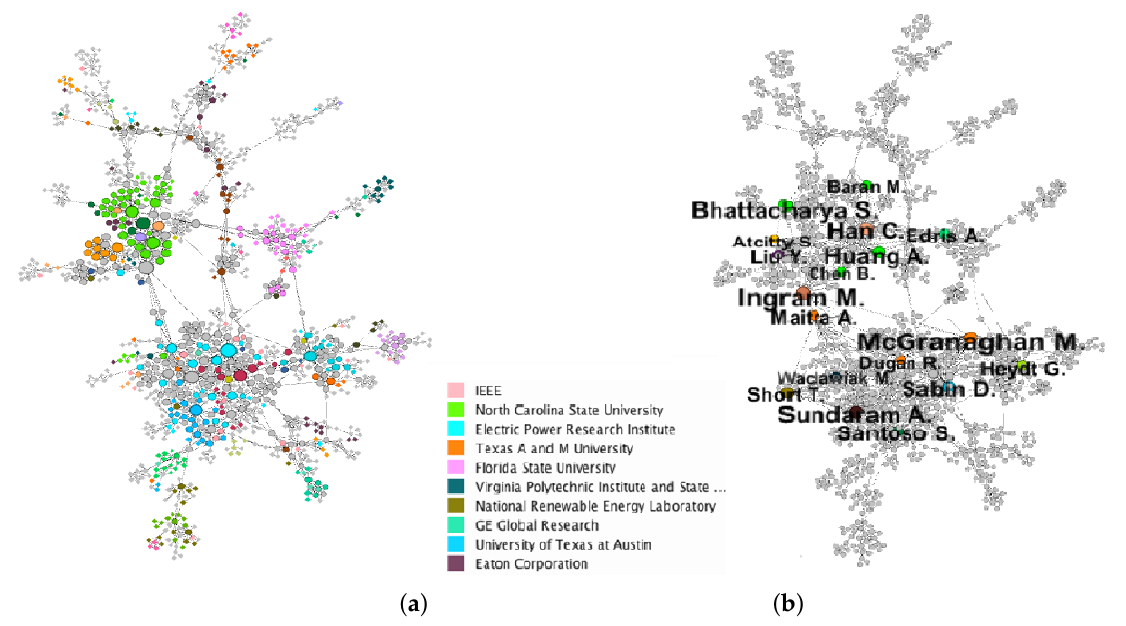
Figure 9. ( a ) collaborations among North American researchers working in power quality; ( b ) researchers with eigenvector centrality value above